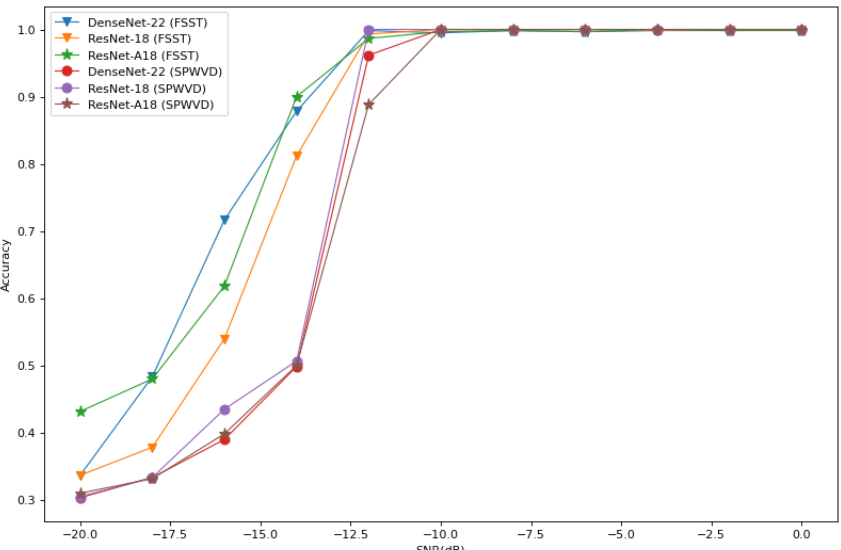
Figure 15. The average recognition accuracy curves of ResNet-A18, DenseNet-22, and ResNet-18 combined with the FSST and SPWVD preprocessing methods in environments with different SNRs.